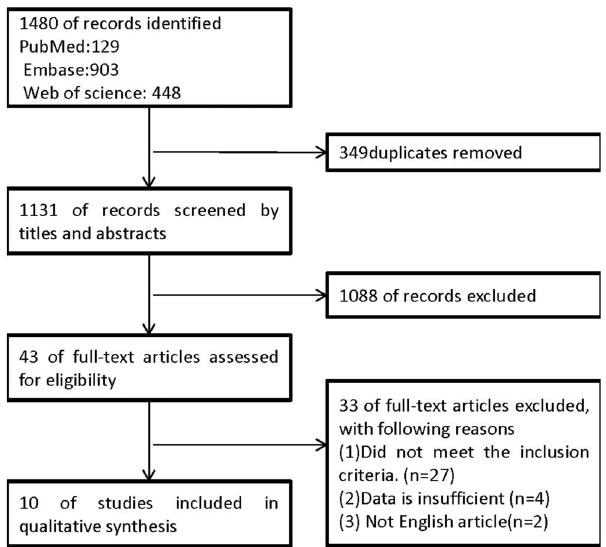
Figure 1. The flow chart for the selection of studies used in the